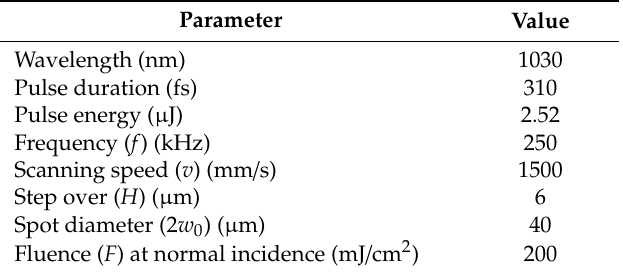
Table 1. Laser process parameters.